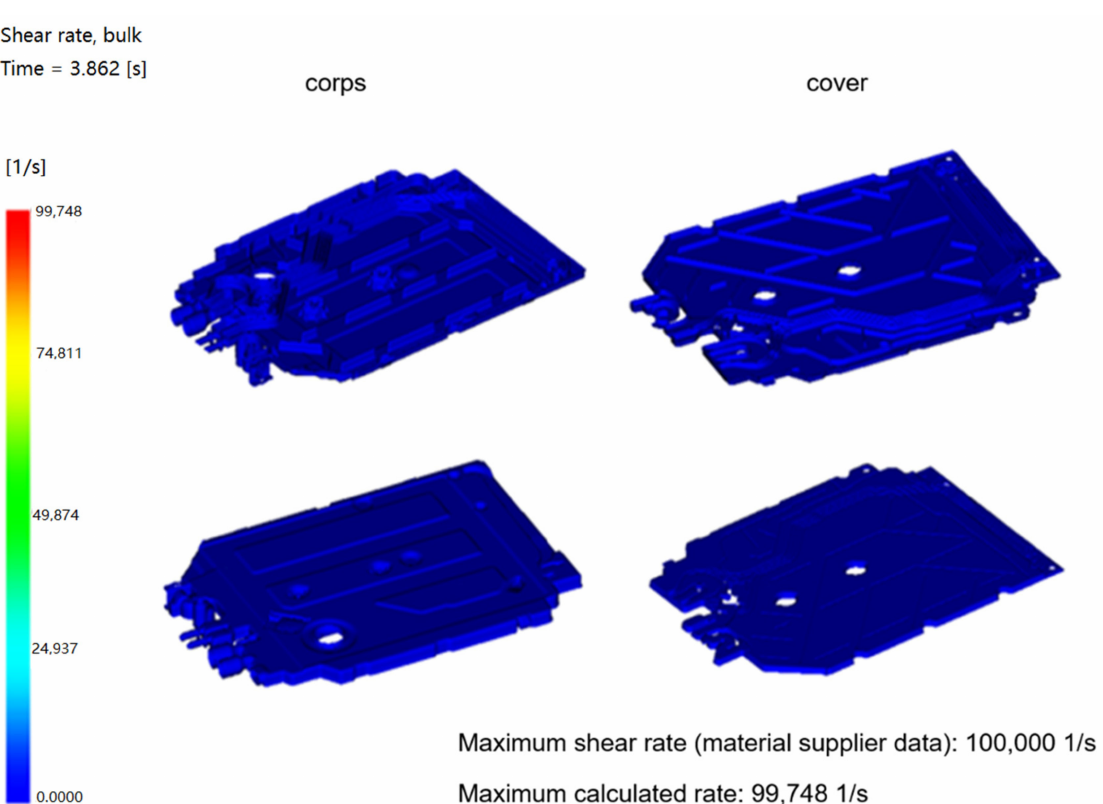
Figure 19. Shear